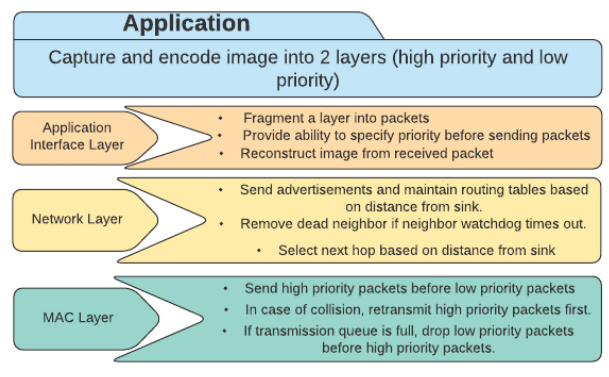
Figure 2 . PRoFIT